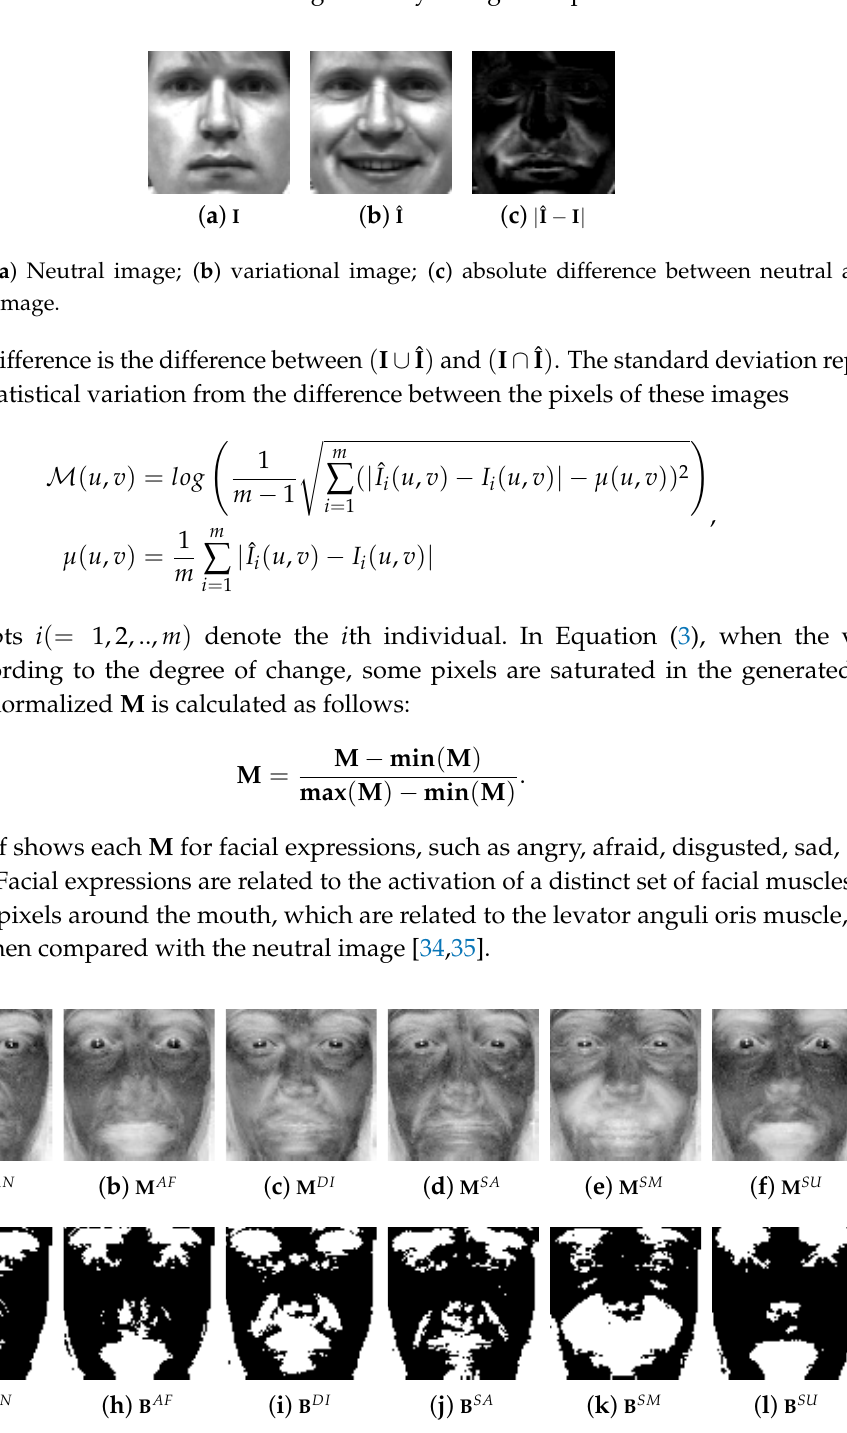
Figure 3. Weighted interpolation maps ( M ) and binary weighted interpolation maps ( B ) for facial expressions. ( AN : angry, AF : afraid, DI : disgusted, SA : sad, SM : smiling, SU :